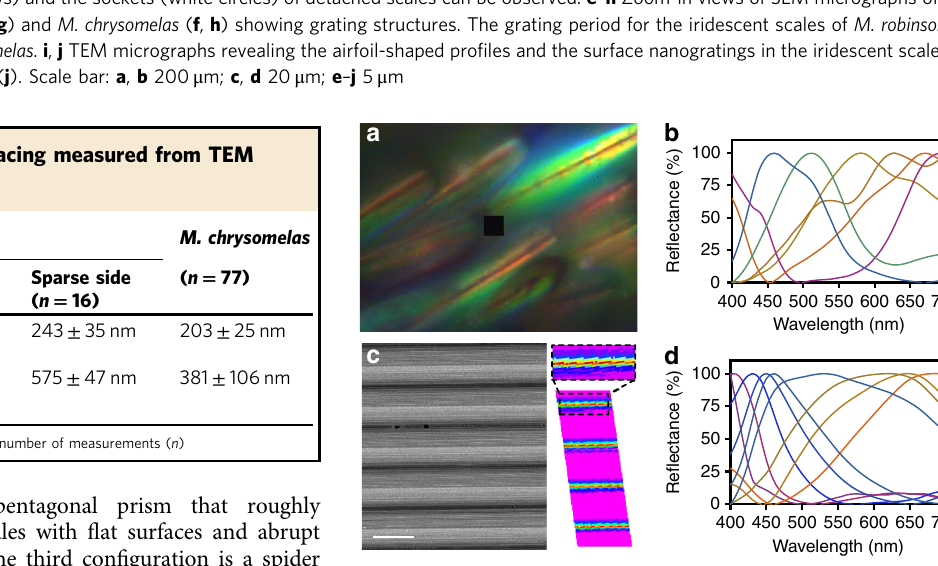
Fig. 3 Observed microscopic colour patterns. a Light micrograph of rainbow patterned M. robinsoni scales. Black centre square: 4 × 4 μ m 2 . b Re fl ectance spectra collected by hyperspectral imaging of the iridescent scales. c SEM micrograph of the 3D printed foil grating (left, scale bar: 10 μ m), and a hyperspectral image of the 3D printed foil grating (right) showing arbitrarily assigned, false-colour rainbow patterns emerging from the tip of the foil grating. Pixels show the same false-colour have the same re fl ectance spectrum and vice versa. d Re fl ectance spectra collected by hyperspectral imaging from the entire 3D printed foil grating image. For b , d the colours of the curves are estimated based on the “ spec2rgb ” function in R script “ pavo ” 49